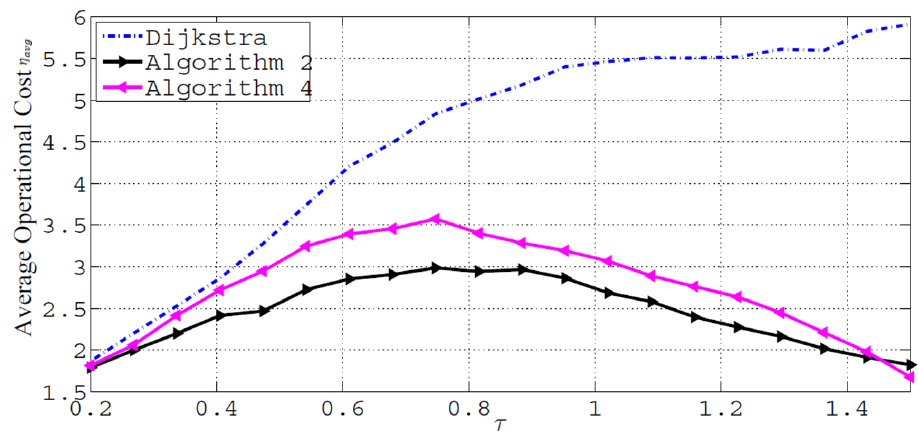
Figure 8. Average operational cost versus risk threshold.